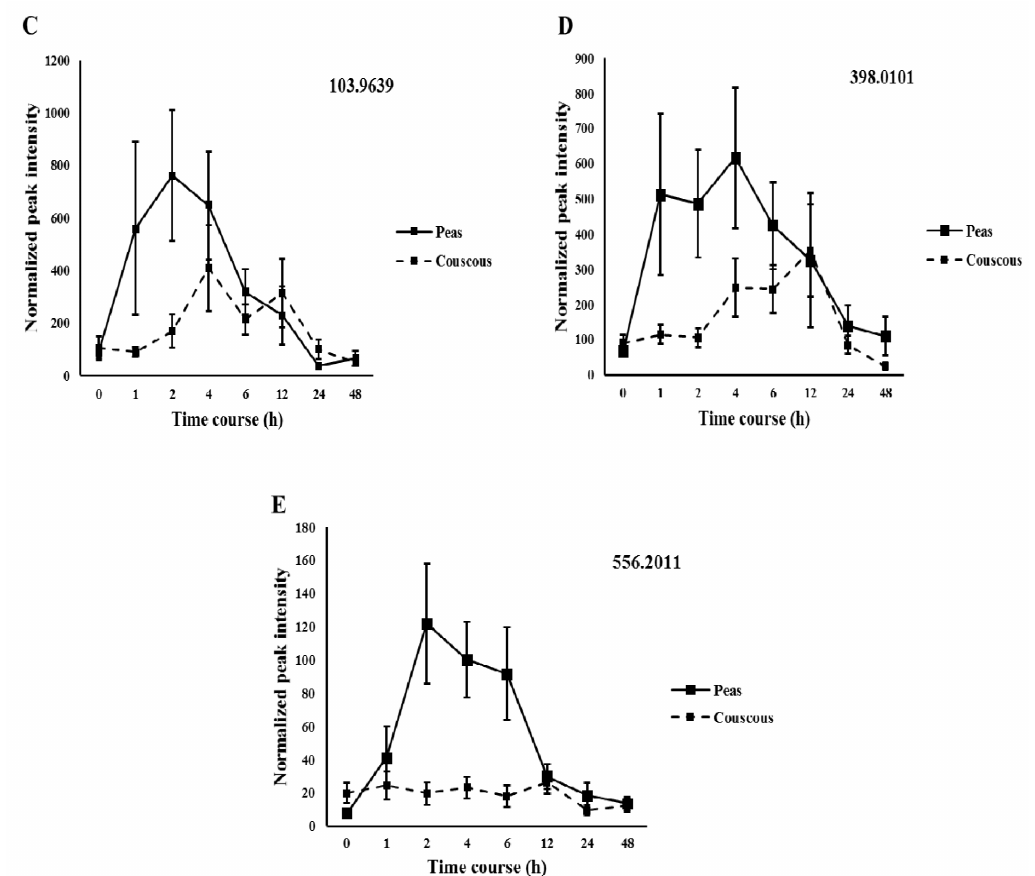
Figure 2. Kinetics of the selected discriminating negative ion mode features obtained from the discovery study represented with accurate mass (176.06838 ( A ); 231.1221 ( B ); 103.9369 ( C ); 398.0101 ( D ); and 556.2011 ( E )) after pea intake and compared with control food couscous ( p < 0.05). Values are mean ± SEMs. X-axis values represent time course in hours and Y-axis values represent osmolality normalized peak intensity.